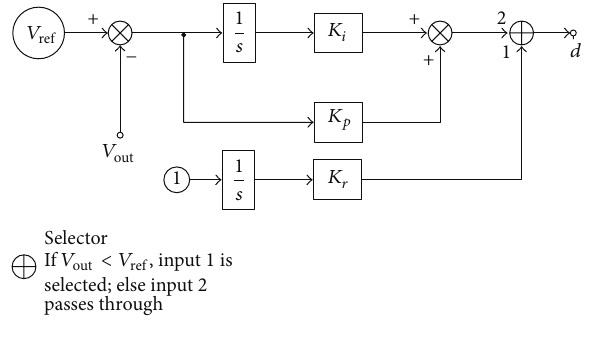
Figure 7: Buck mode